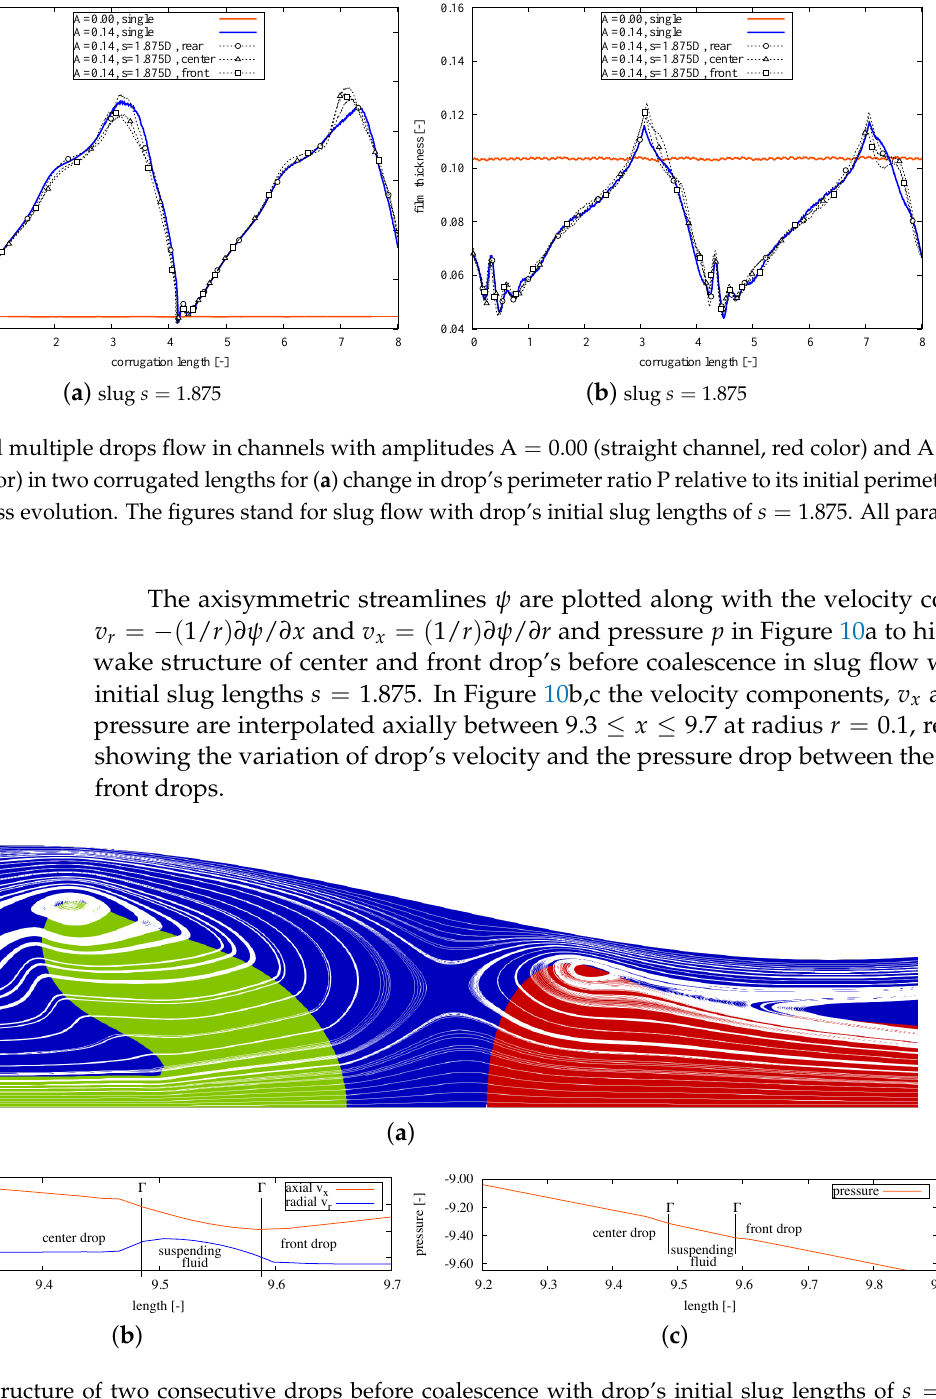
Figure 10. Wake structure of two consecutive drops before coalescence with drop’s initial slug lengths of s = 1.875. ( a ) Axisymmetric streamlines ψ of the center and front drops, ( b ) velocity components v x and v r interpolated axially between 9.3 ≤ x ≤ 9.7 at radius r = 0.1, and ( c ) pressure distribution interpolated axially between 9.3 ≤ x ≤ 9.7 at radius r =